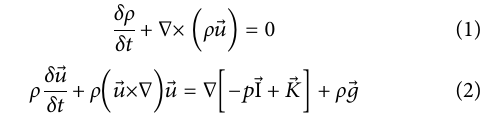
FIGURE 3 Matrix-type microscopic pore